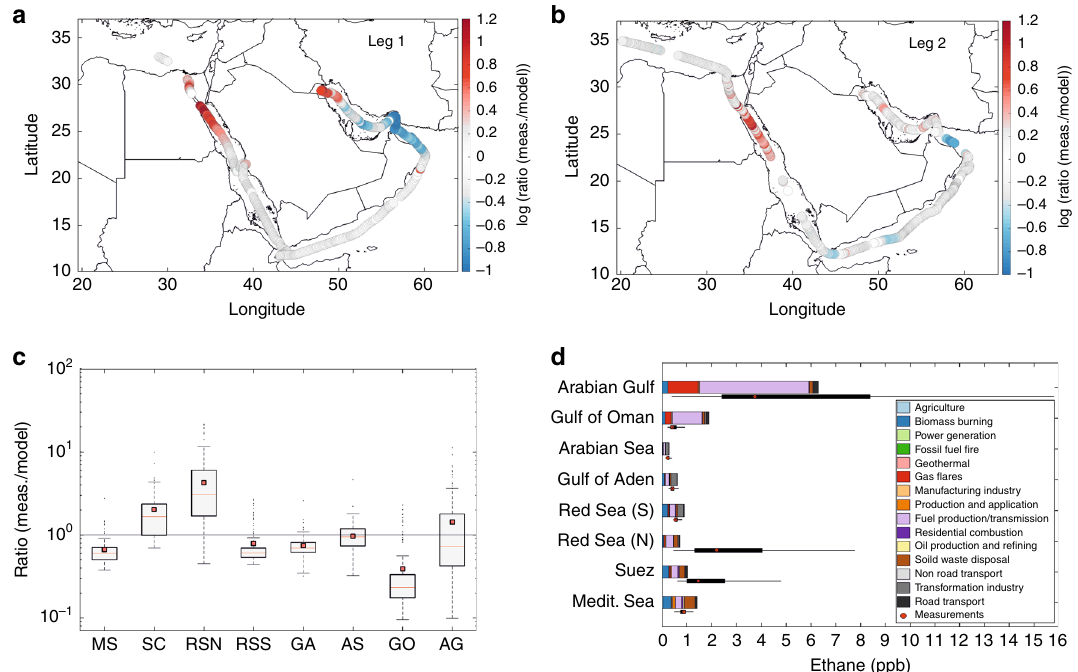
Fig. 1 Comparison between ethane measurements and model simulations. Timeline ratios are displayed for both leg 1 ( a ) and leg 2 ( b ). In c , geospatial ratio statistics are displayed with the boxplots that illustrate the median with red line and the mean with red squares. The bottom and top edges of the box indicate the 25th (q1) and 75th (q3) percentiles, respectively. The boxplot draws points as outliers if they are greater than q 3 + w × ( q 3 − q 1) or less than q 1 − w × ( q 3 − q 1). The whiskers correspond to ±2.7 σ and 99.3% coverage if the data are normally distributed. In d , geospatial measured volume mixing ratios of ethane are shown with black boxplots where the red circles are the median measured values and the whiskers are de fi ned as in ( c ). The modeled mixing ratios are in bars for each emission